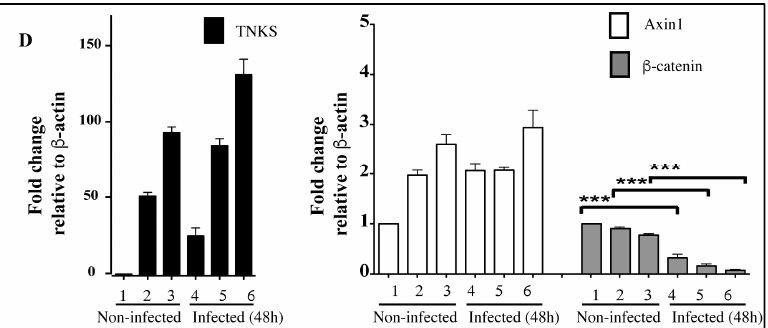
Figure 6. HCMV-induced TNKS accumulation correlates with decreased β -catenin. Western blot showing levels of Wnt proteins (TNKS, Axin1, β -catenin) in infected HFFs ( A ) and IST-1 ( B ) cells. XAV939 (0.1 and 1 μ M) and Salinomycin (0.1 μ M) were used as modulators of Wnt. TNKS accumulates in response to HCMV infection and β -catenin is reduced upon infection; ( C ) and ( D ) show the quantification of ( A ) and ( B ) respectively from three representative experiments. Data plotted is mean ± standard error, SE. Lane numbers in Western blot figures correspond to lane numbers in quantification plots. * indicates p value < 0.05, ** indicates p < 0.01, and *** indicates p < 0.001, for changes in β -catenin.